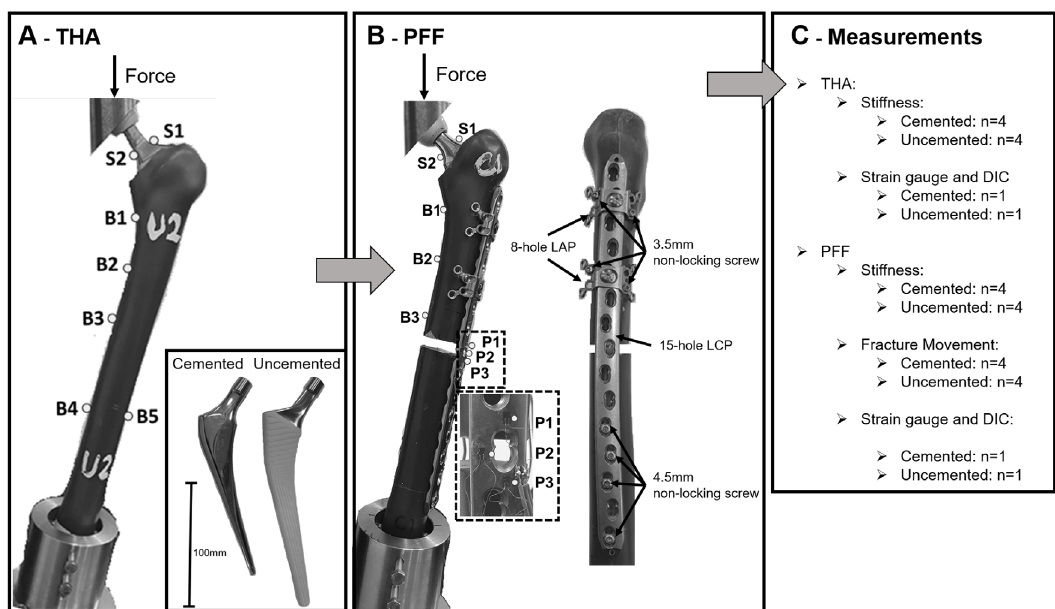
Figure 1. Overview of the study. Experimental setup of total hip replacement (A) and periprosthetic femoral fracture fi xation (B). S1 – S2 highlight strain gauge attachment site on the stem, B1 – B5 highlight strain gauge attachment site on the bone, and P1 – P3 highlight strain gauge attachment site on the fracture